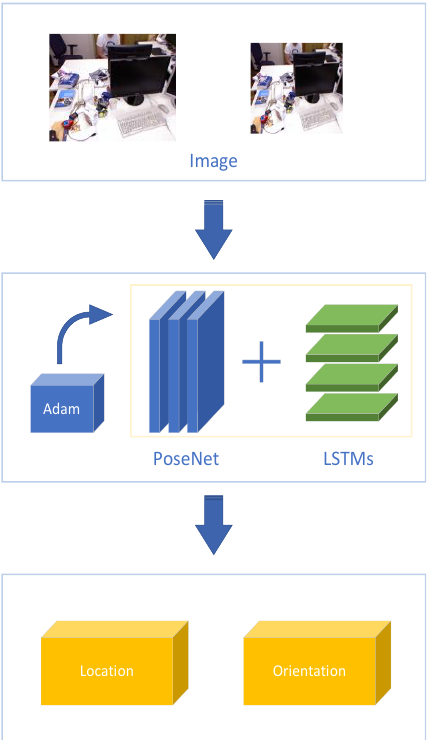
Figure 1 . Architecture of the proposed method.